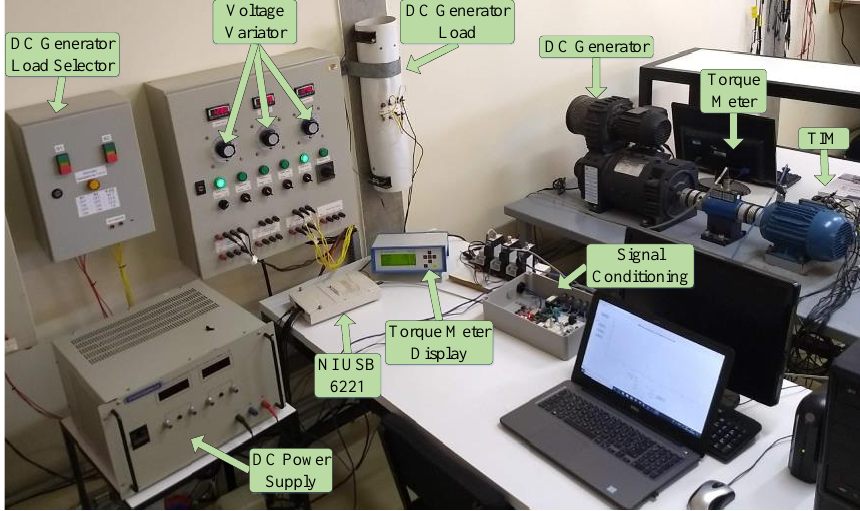
Figure 2. Workbech used for collecting the experimental data